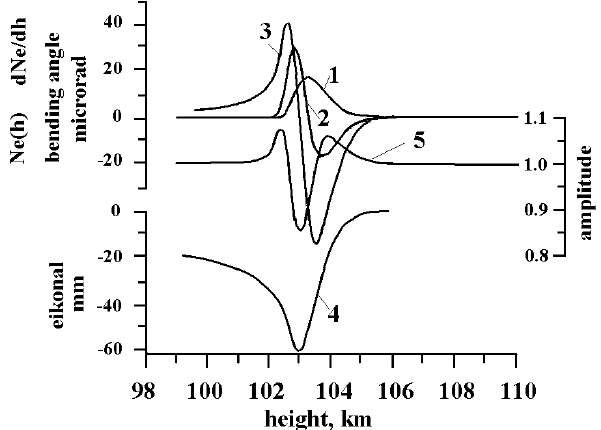
Fig. 7. Simulation of the ionospheric impact on the RO signal as a function of the altitude of the RO ray perigee by the analytical model. Curve 1 and 2 are relevant to the altitude distribution of elec- tron density N e (h) [10 3 elcm − 3 ] and its vertical gradient dN e (h) [10 3 elcm − 3 km − 1 ], respectively. Curves 3–5 describe the altitude dependence of the bending angle [microradians], eikonal excess [mm], and amplitude of the RO signal [normalized],